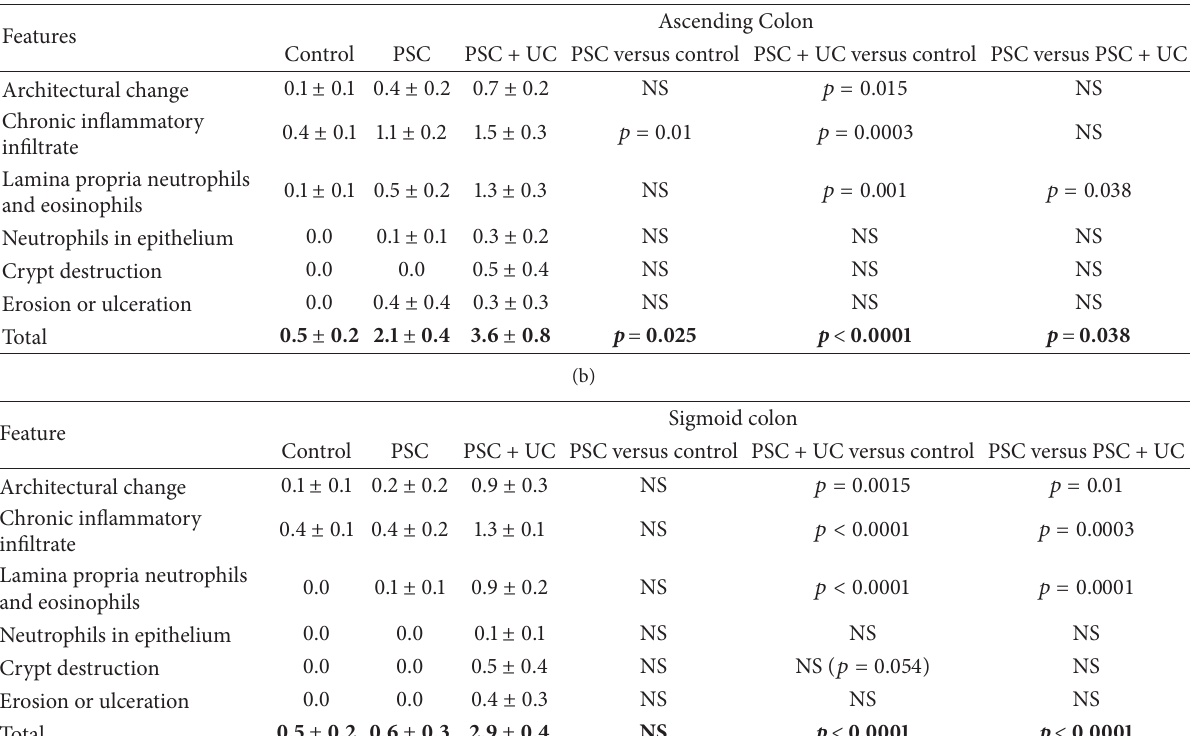
Table 2: Histological assessment of epithelial and inflammatory features in ascending colon (a) and sigmoid colon (b) of PSC patients without or with ulcerative colitis (PSC + UC). Values indicate the mean of scoring system ±